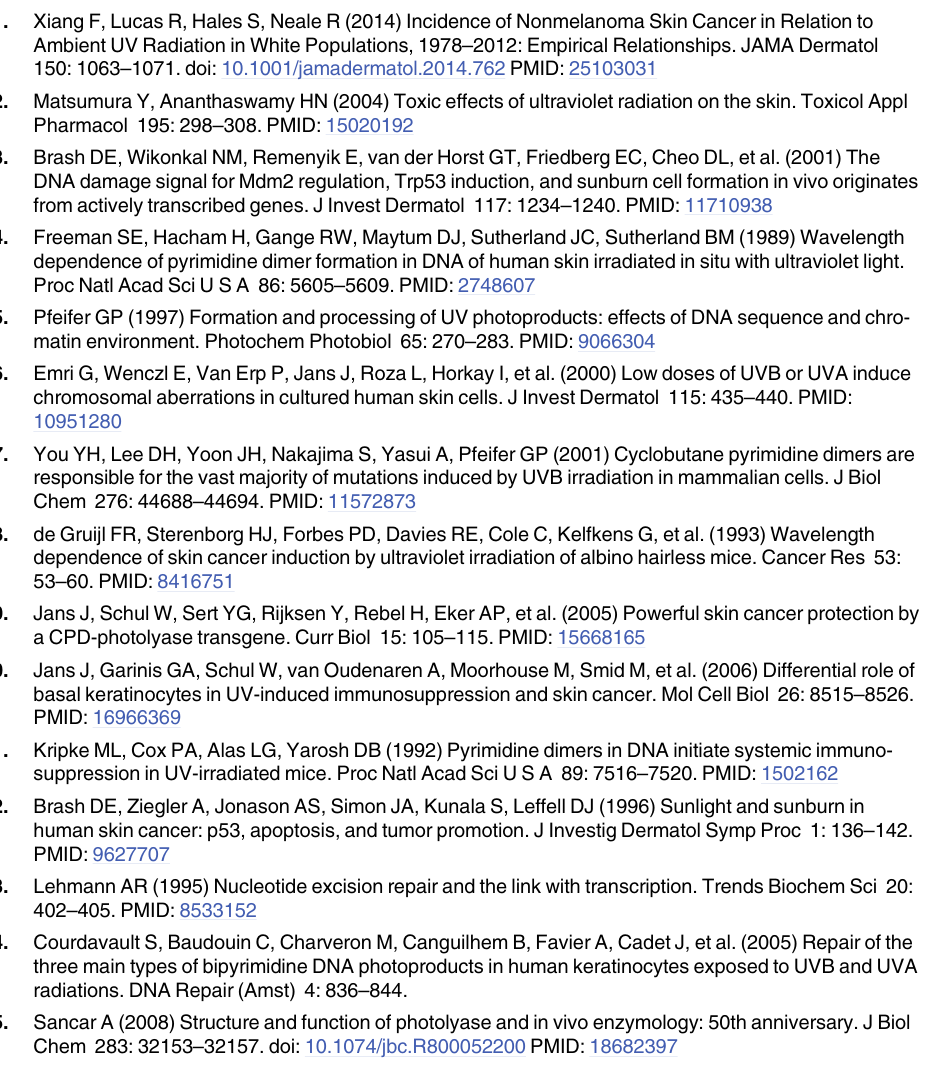
S1 Table. List of all up and downregulated genes related to CPD lesions determined in CPD-PL C -mRNA transfected human keratinocytes at 6 h after UVB exposure by microar- ray analyses. S2 Table. List of all up and downregulated genes related to CPD lesions determined in CPD-PL C -mRNA transfected human keratinocytes at 24 h after UVB exposure by micro- array